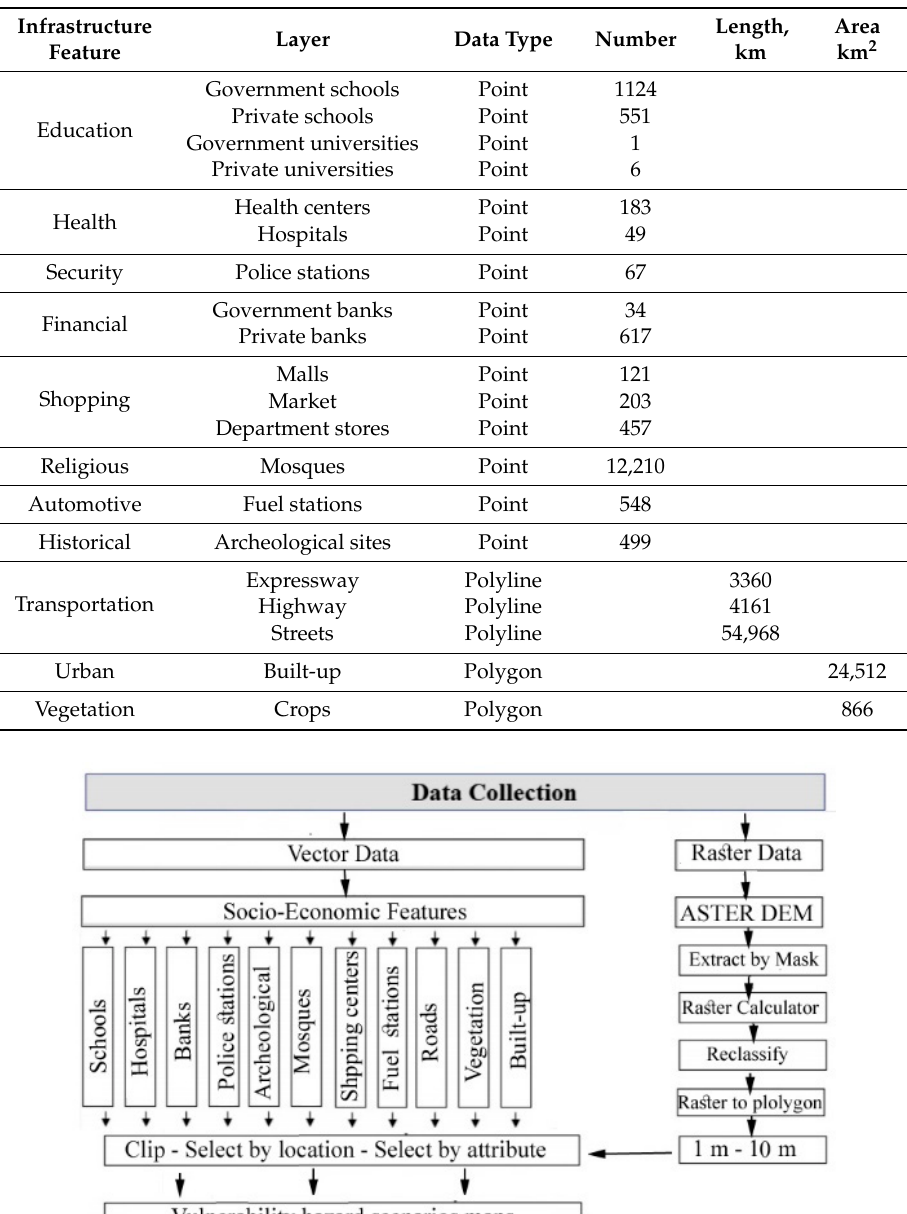
Table 1. The infrastructure database of Oman as provided by [46].